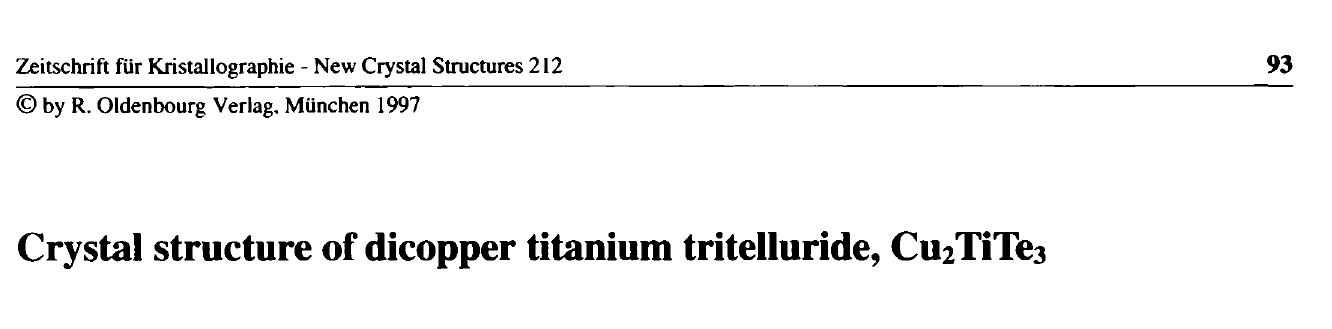
Source of material: A 250 mg charge of Rb2Te3, Cu, Ti, and Te ground together in a 2 :3 : 2 : 5 ratio was sealed in a fused-silica tube. The tube was heated at 973 Κ for 6 days and cooled to room temperature at 4 K/h. The Cu2MTe3 (M=Ti,Zr,Hf) group of isostructural compounds was first synthesized by Keane and Ibers (see réf. 1 ) who obtained a complete structural solution for Cu2HfTe3 and the following cell parameters f«-Cu2TiTe3: a= 19.73(3) Â, b=3.970(4) Â, c=7.076(4) Â, β = 95.7(1)°.